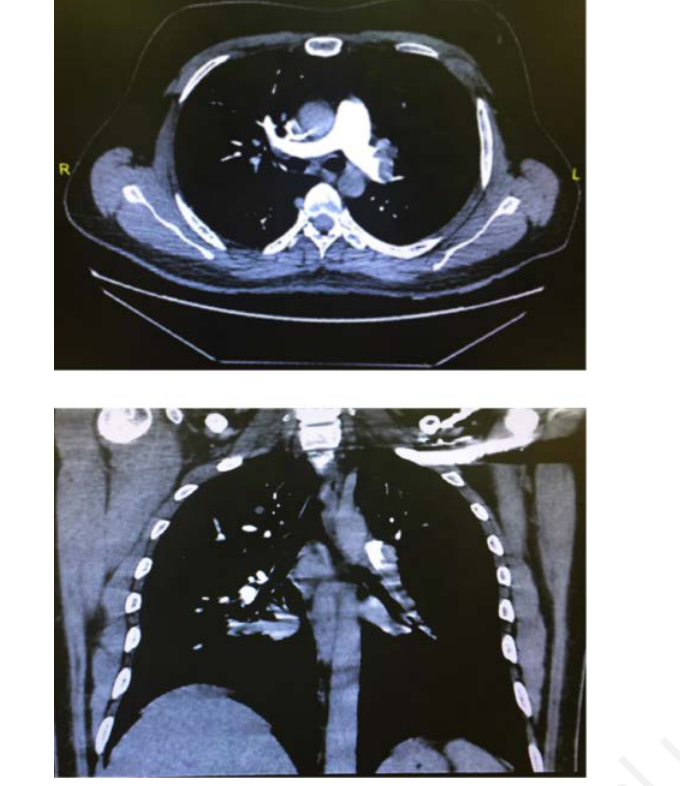
Figure 1. A CT pulmonary angiography scan showed filling defects at the left main pul- monary artery, left lobar, segmental, and subsegmental